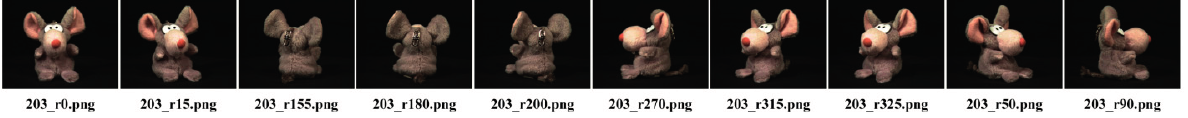
Figure 8. The 10 selected views of Class 203 of the ALOI-1000